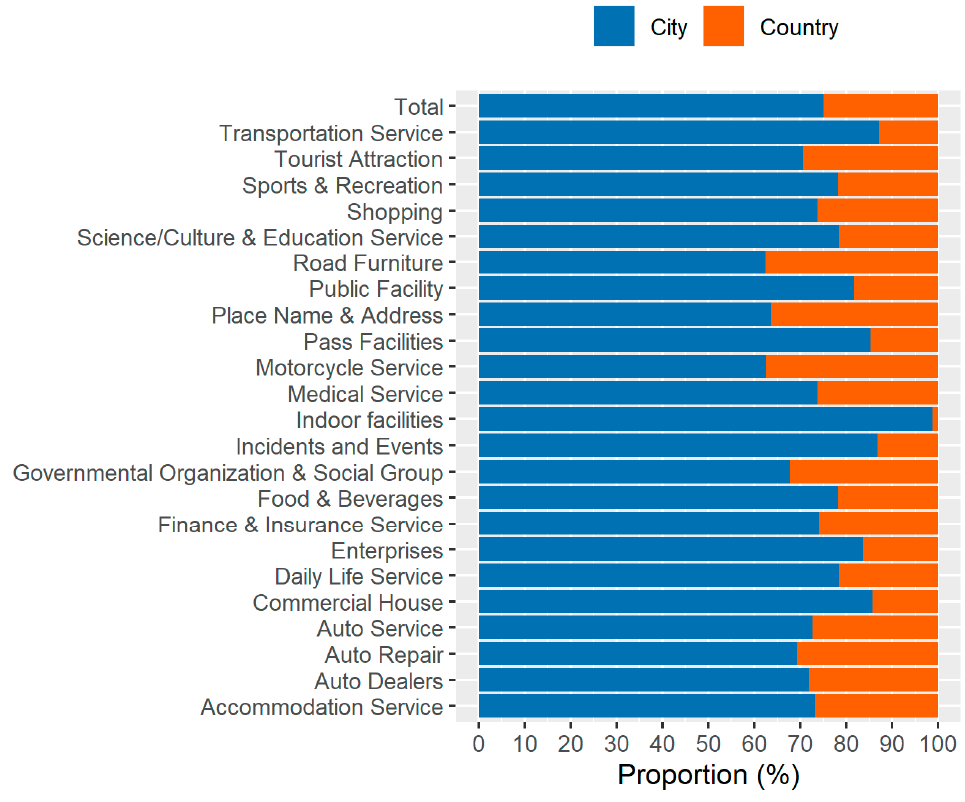
Figure 6. The proportion of the POI data which are located in urban built-up areas and non-built-up areas for various POI categories in the whole of China in May 2019.